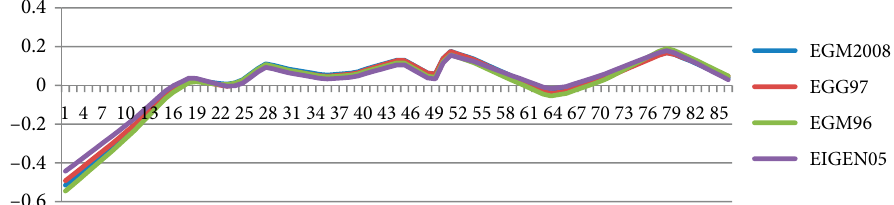
Fig. 10. Deviation of geoid heights N(m) from actual DEM a latitude 42.60